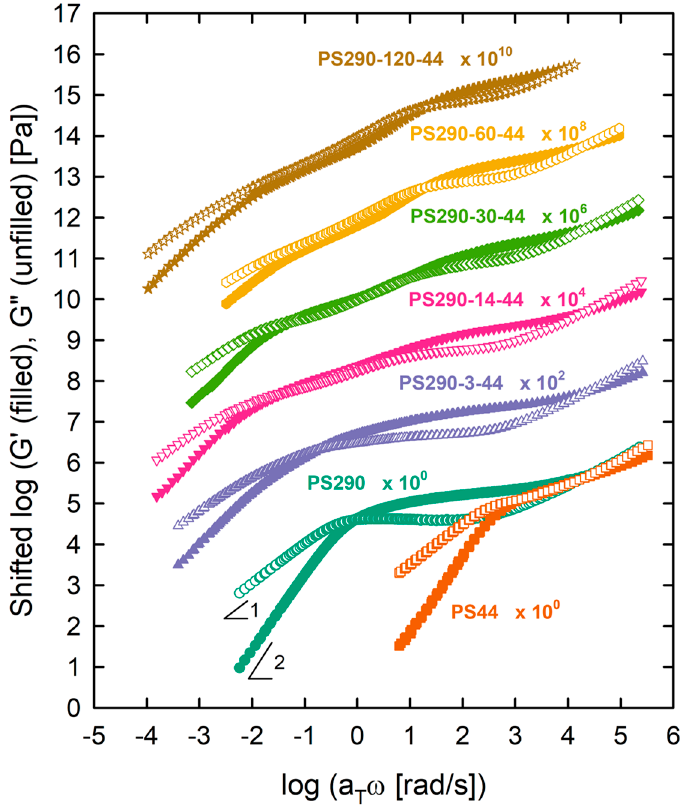
Figure 1. Linear master curves of model comb PS set at T ref = 180 °C. Moduli were shifted vertically for clarity of presentation.